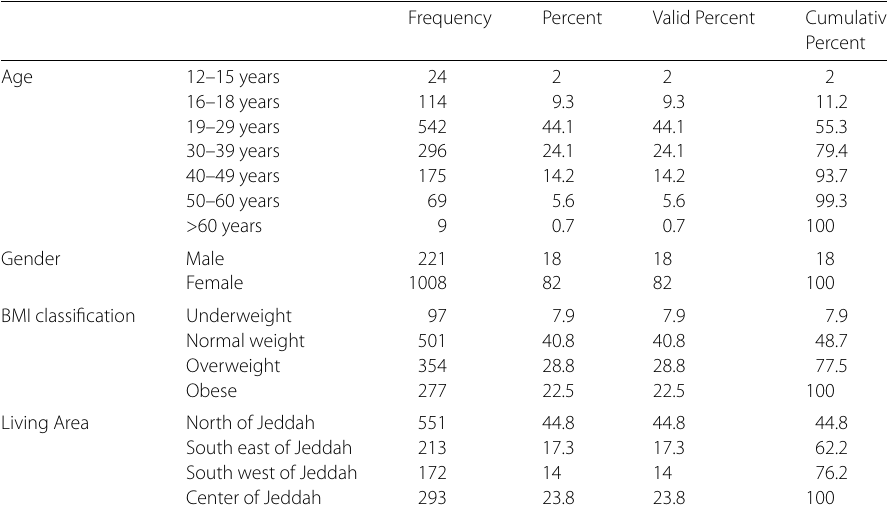
Table 1 Demographic data of